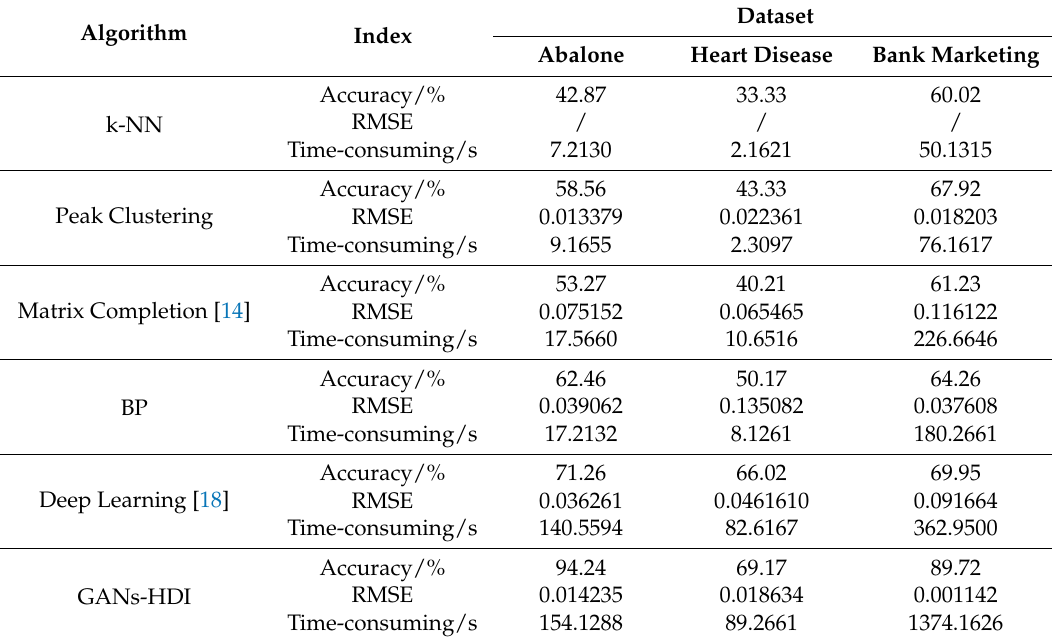
Table 4. Comparison of four algorithms on UCI